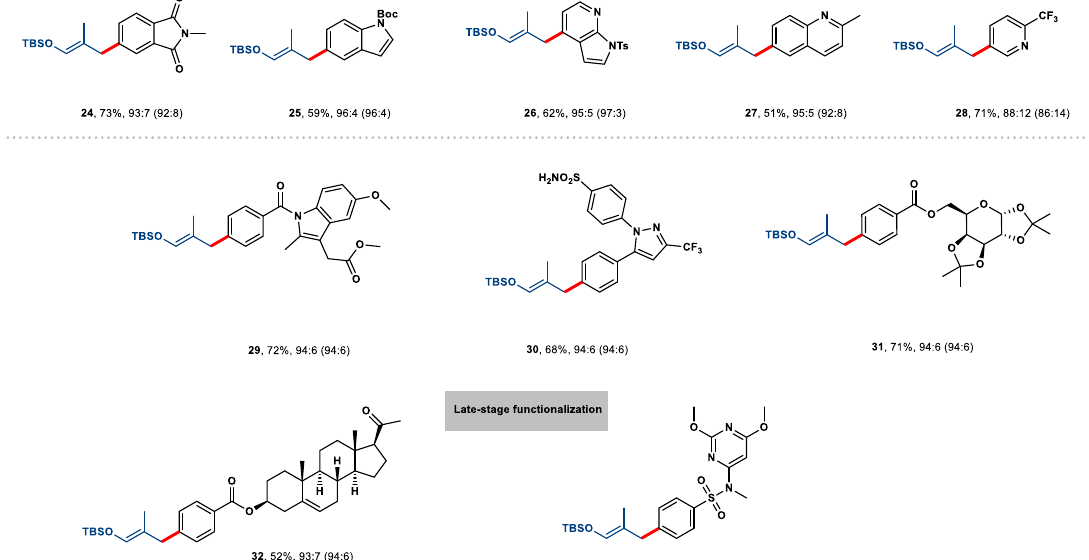
(1mol%), NiBr 2 (10mol%), dtbbpy (15mol%), benzene/THF 1:1 (2mL), rt, 48-72h, yieldsand E / Z after puri fi cationbychromatography (numbersin parenthesesrefer to E / Z before puri fi cation). Ac, acetyl group; TBS, tert -butyldimethylsilyl.